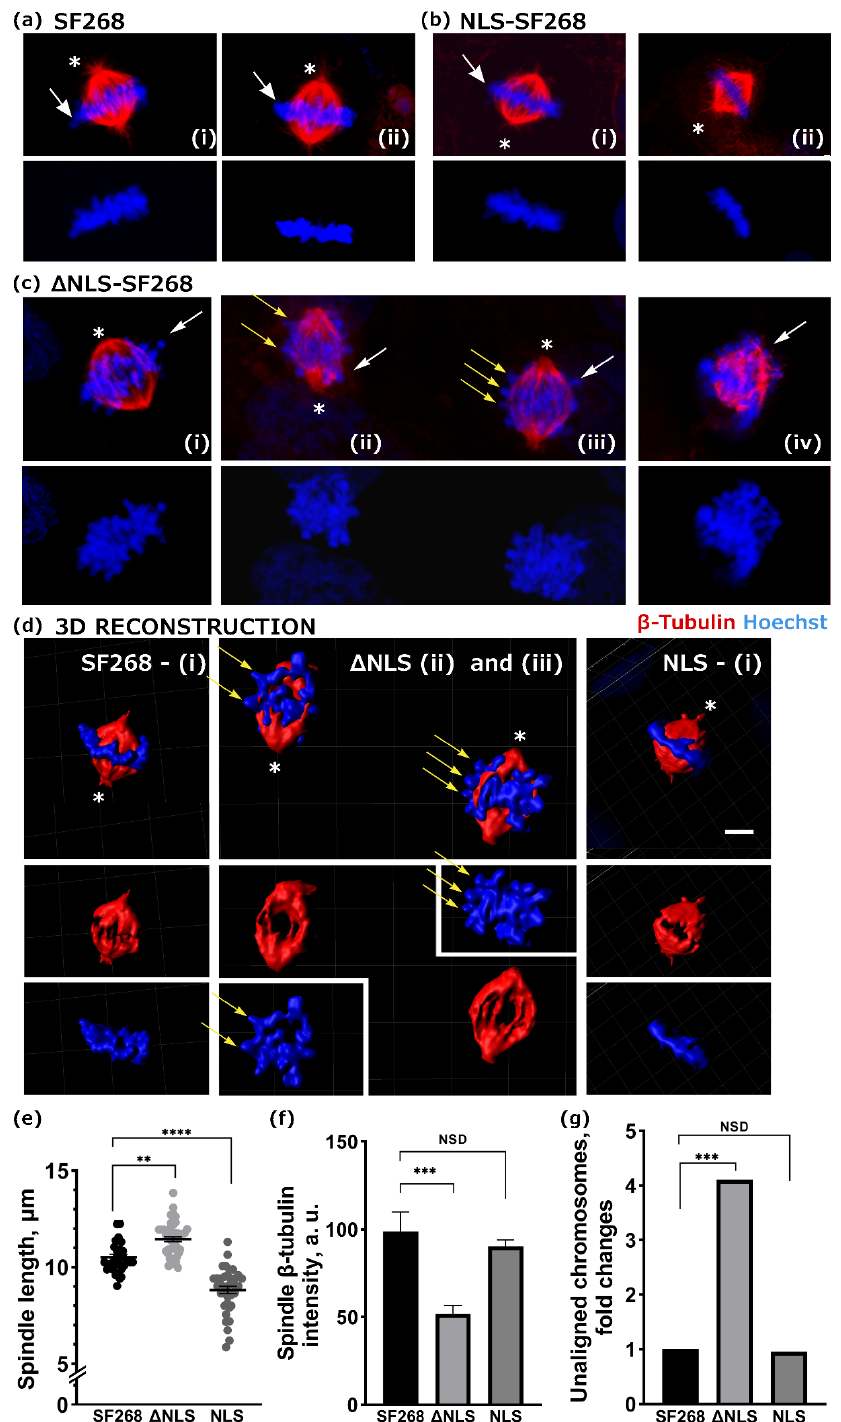
Figure 4. Spindle MT properties and configuration, and chromosome congression are regulated by NLS neurofibromin isoforms. Immunofluorescence confocal images of synchronized cells in metaphase treated with DSP and stained for β-tubulin (red) and chromatin (blue) of ( a ) SF268, ( b ) NLS, and ( c ) ∆ NLS-SF268 cells. SF268 parentals and NLS-SF268 cells have astral MTs emanating from the spindle poles (asterisks) and proper chromosome congression at the spindle equator (white arrows). ∆ NLS cells lack astral MTs (asterisks) and display abnormal chromosome congression (yellow arrows); Latin numerals in panels label individual spindles. ( d ) 3D reconstructed confocal images of metaphasic cells, using IMARIS. Yellow arrows show abnormal chromosome congression and asterisks astral